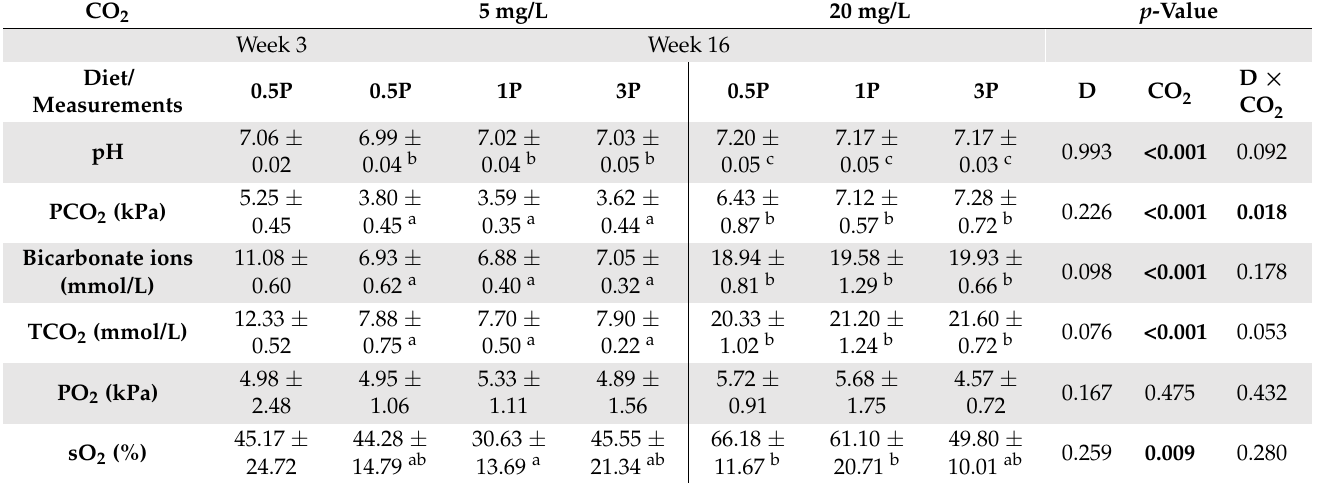
Table 6. Whole blood analysis (iSTAT). Listed values for pH, PCO 2 (partial pressure of CO 2 ), bicarbonate ions, TCO 2 (total CO 2 ), PO 2 (partial pressure of O 2 ), and sO 2 (O 2 saturation) of Atlantic salmon at weeks 3 and 8 fed different levels of total phosphorus (P) 0.5P (6.3 g/kg), 1P (9.0 g/kg), and 3P (26.8 g/kg) and reared in conditions with no CO 2 injected (5 mg/L) or with injected CO 2 (20 mg/L). The statistically significant differences among groups (within a row) are indicated by different lowercase superscript letters. If none of the letters are the same, differences are